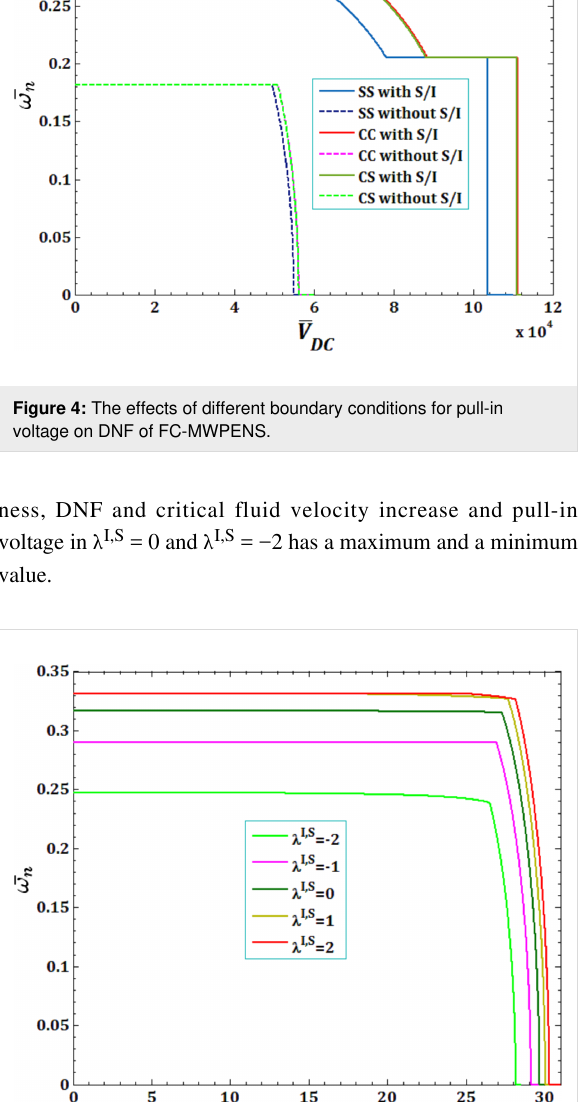
Figure 5: The effects of surface/interface Lame’s constants λ I,S for fluid velocity on DNF of SS